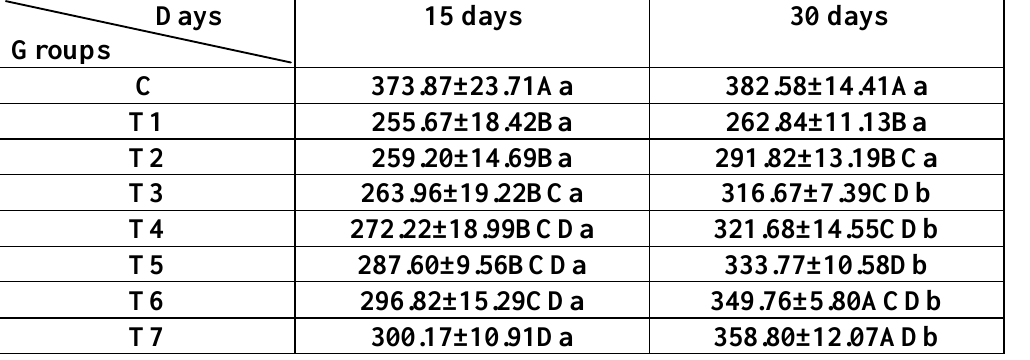
-LSD=7.111. - C= control. -T1= Animal Injected iron dextran 100 mg/kg B.W + Polyphenol 75 mg/kg. - T2= Animal Injected iron dextran 100 mg/kg B.W + Polyphenol 100 mg/kg. -T3=Animal Injected iron dextran 100 mg/kg B.W + Polyphenol 125 mg/kg. -T4= Animal Injected iron dextran 100 mg/kg B.W